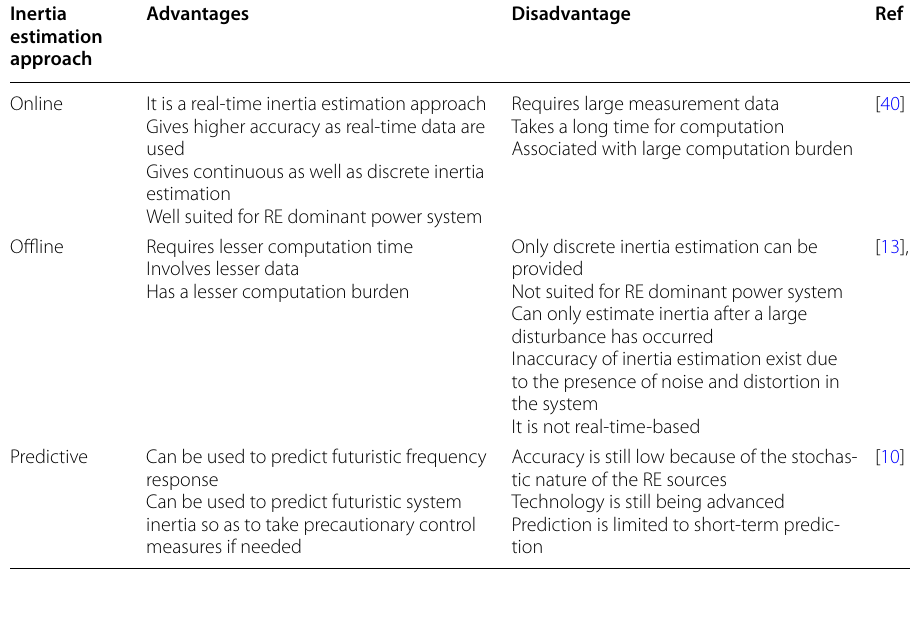
Table 5 Inertia estimation techniques and their characteristics Inertia estimation